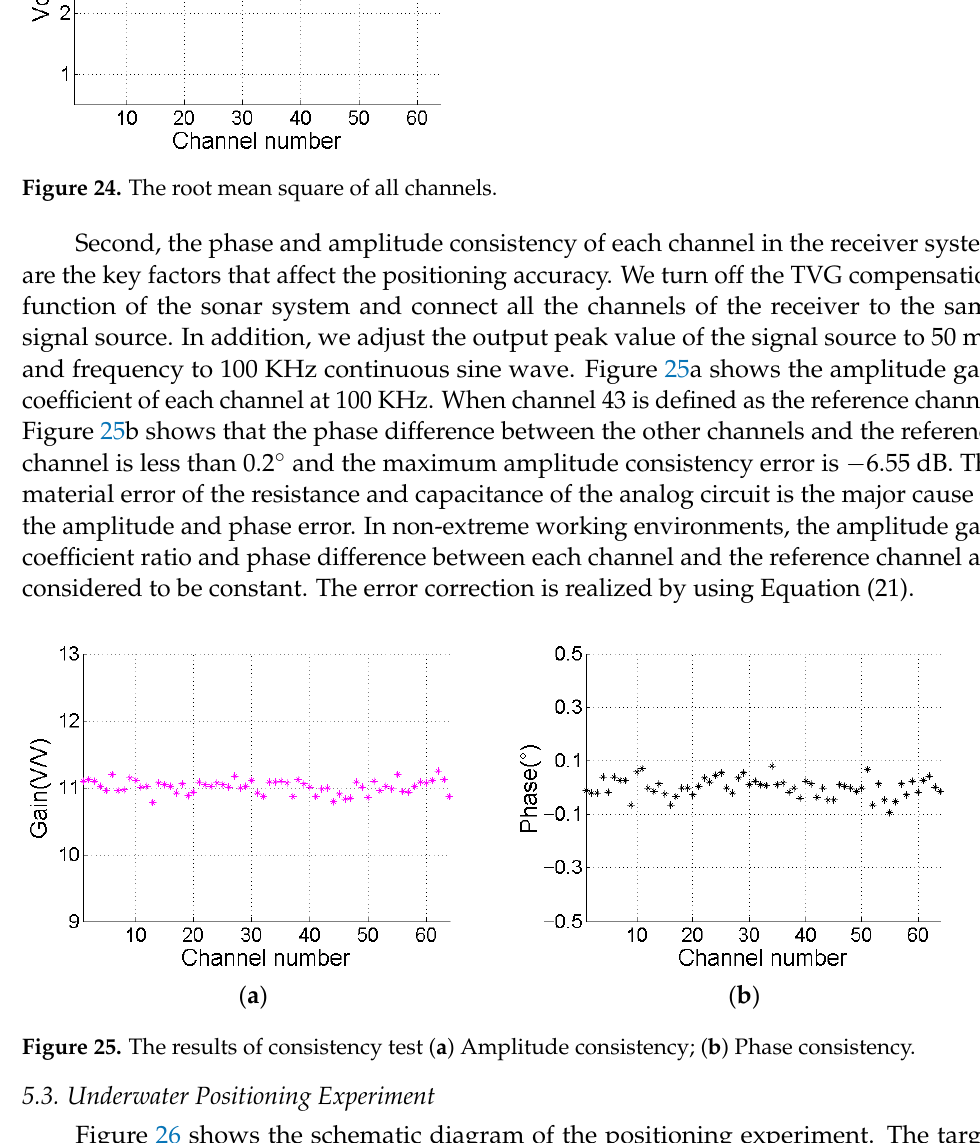
Figure 24. The root mean square of all channels.